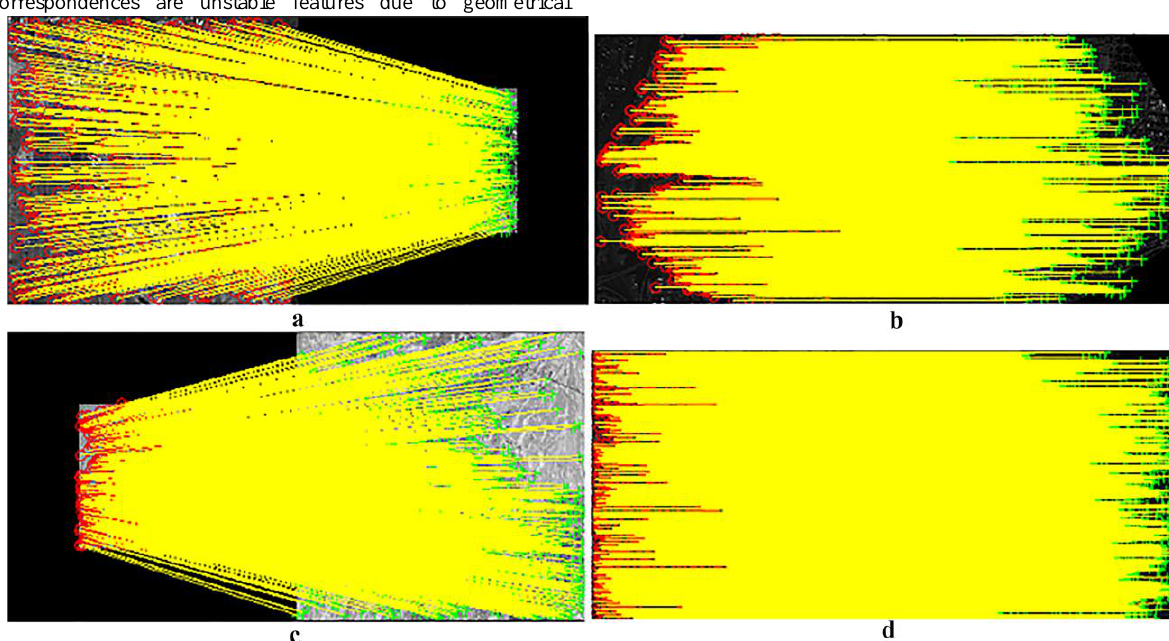
Figure 8. visualization of correct matches identified by HardNet8. The first row from left to right relate to pairs a and b, and the second row from left to right relates to pairs c and d,